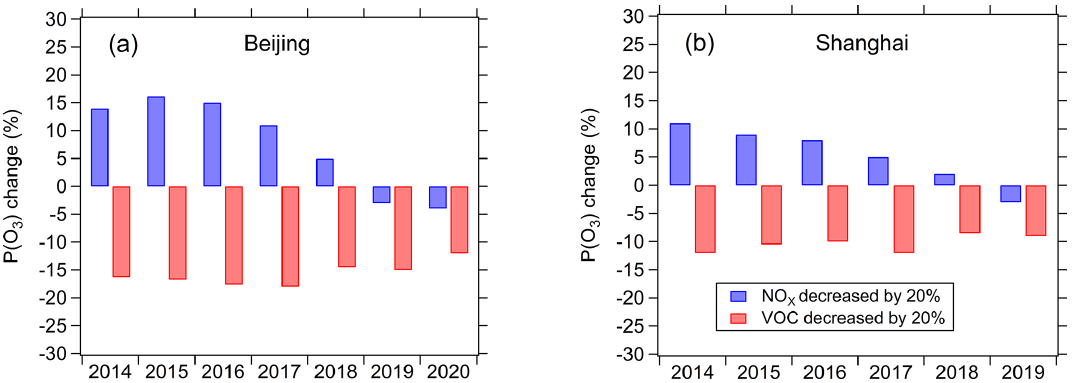
Figure 9. Sensitivity of summertime mean daytime net ozone production rate [ P (O 3 )] to VOCs and NO x simulated by the photochemical box model during 2014–2020 in Beijing (a) and Shanghai (b) . The VOCs and NO x are decreased by 20% to test the fractional change of P (O 3